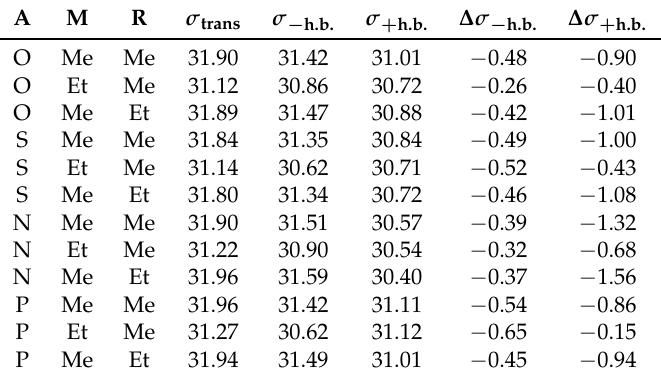
Table 4. Absolute and relative M06-2X/TZ isotropic NMR chemical shielding constants for the hydroxyl H atom ( σ and ∆ σ in